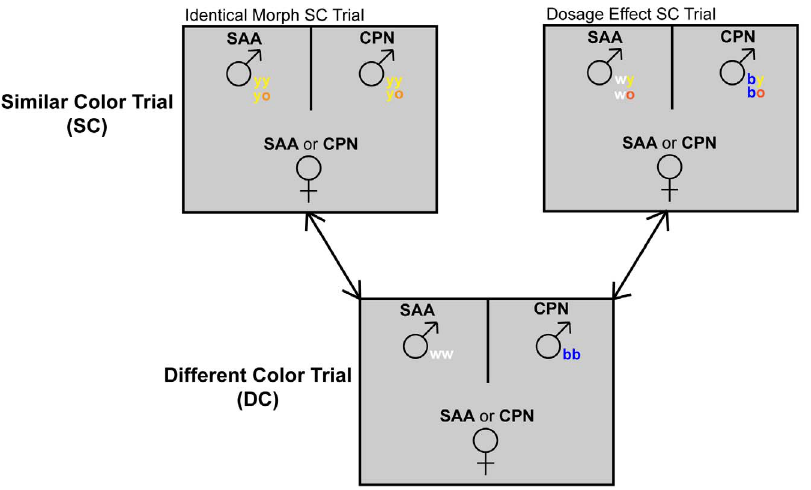
Figure 3. Schematic representation of our mate choice experiment. All females participated in one SC trial and one DC trial, each of which included two males, one from SAA and one from CPN. In all cases, DC trials included a pure blue male from CPN and a pure white male from SAA. In trial pairings with an identical morph SC trial, the males included in the SC trial were either both pure yellow or both yellow-orange. In trial pairings with a dosage effect SC trial, the possible male pairings in the SC trial were blue-orange (CPN) vs. white-orange (SAA) or blue-yellow (CPN) vs. white- yellow (SAA).